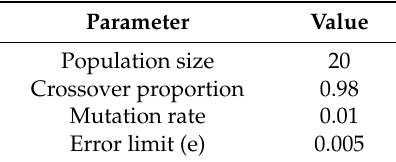
Table 4. Parameters of